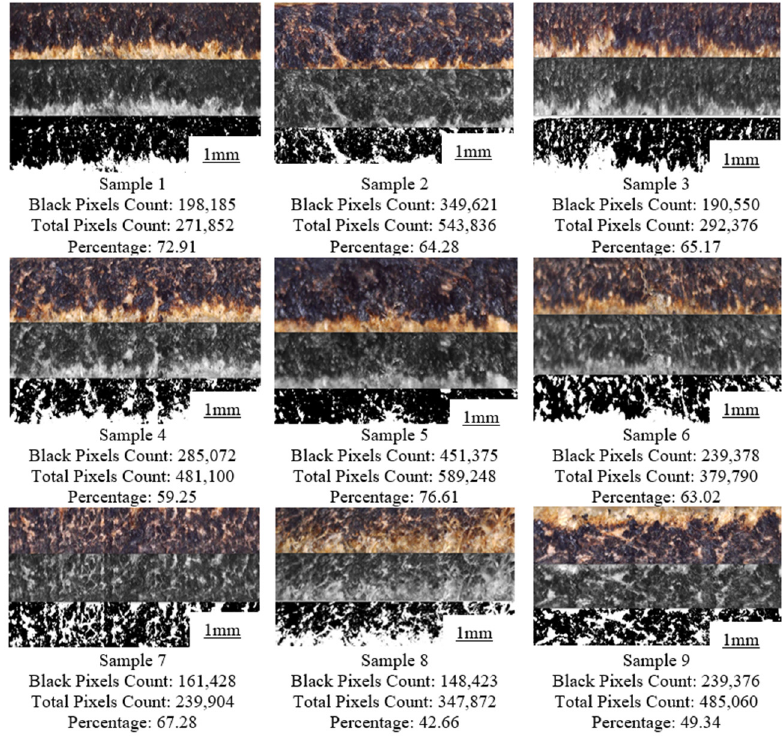
Figure 4. Conversion of captured image to binary image.